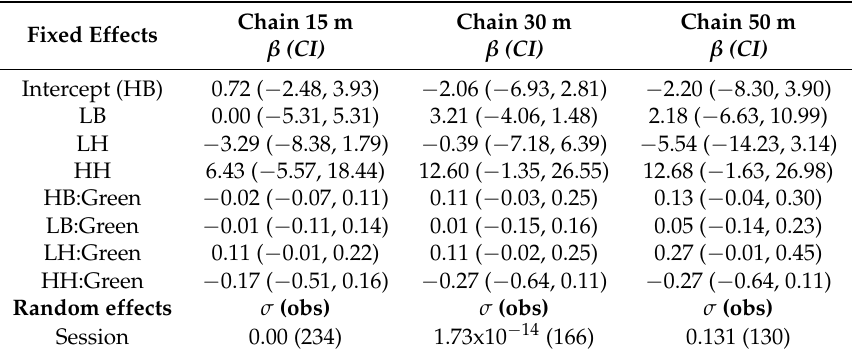
Table 3. Results of LMMs testing for effect of disturbance (High Benign, Low Benign, Low Harm, High Harm) and forage greenness on group size. Each model considered the data using a different chain rule (15 m, 30 m, or 50 m). Effects ( β ) are presented with 95% confidence intervals (method: Wald) which are highlighted a bold when intervals do not cover zero. Categorical fixed effects are relative to reference level (High